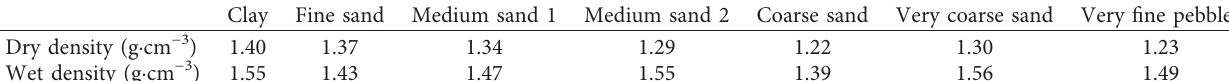
Figure 1: Test sediment. Table 2: Physical properties of sediments.